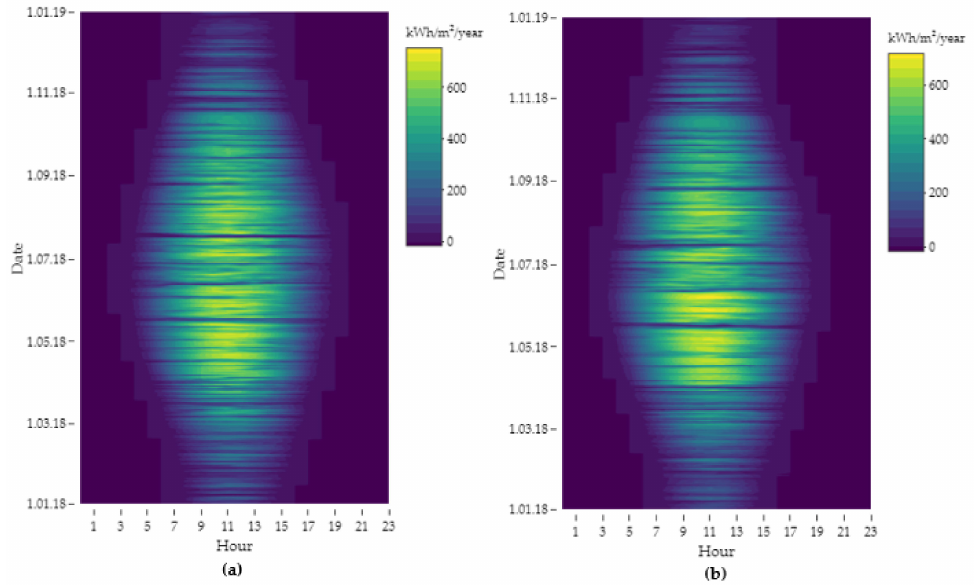
Figure 6. Horizontal insolation for the location of the case study: ( a ) M1, M2, M3 and ( b ) M4. Source: own